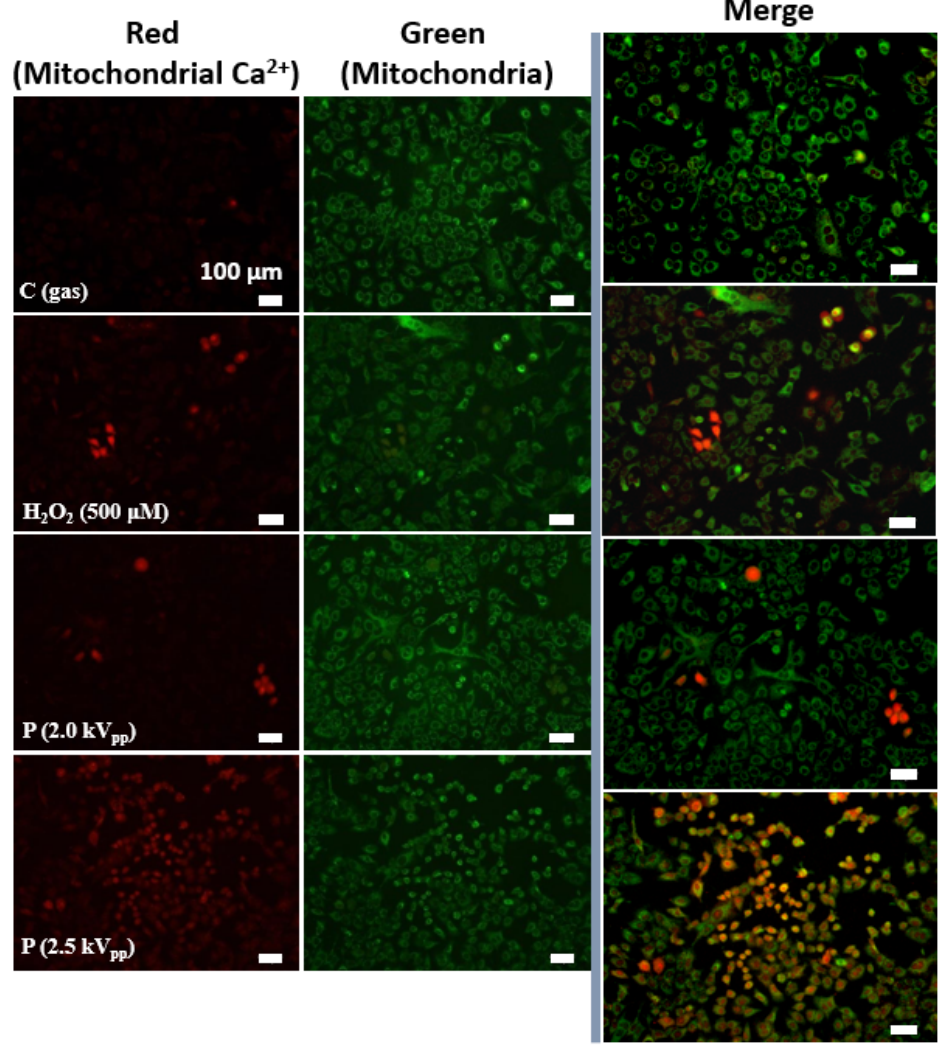
Figure 4. CAP induces the increased mitochondrial Ca 2+ levels in dose-dependent manner in cancer cells. Images of the relative levels of mitochondrial calcium (Ca 2+ ) as a function of the applied voltage in A549 lung cancer cells. Red images represent the detection of mitochondrial calcium (Rhod-2 AM), green images represent the detection of mitochondria (MitoTracker), and orange images indicate colocalization of the two dyes. Hydrogen peroxide (H 2 O 2 )-treated cells were used as the positive control, and gas-only-treated cells were used as the negative control. Scale bar indicates 100 μm.